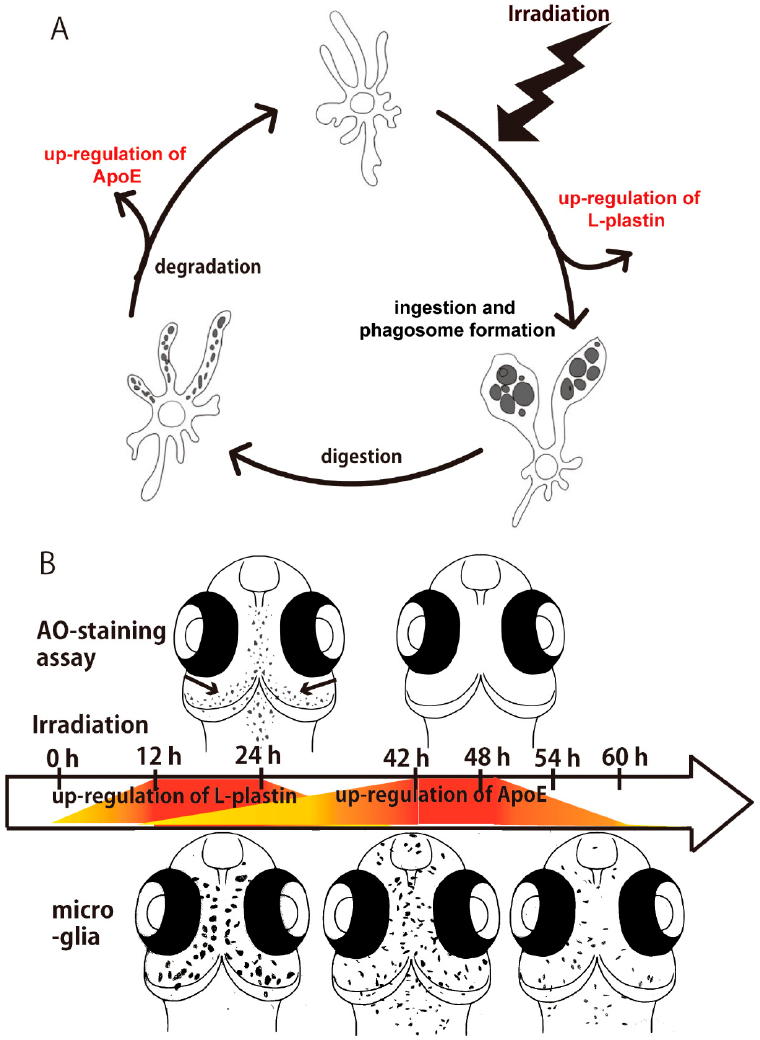
Figure 5. Sequential process of microglial activation in the irradiated medaka embryonic brain. ( A ) Activated microglia ingest apoptotic cells and form phagosomes to digest the cell debris. During the process of phagocytosis, L -plastin may be upregulated at the initial phase of microglial activation, especially in the process of ingestion of apoptotic cells. ApoE is expressed at the later phase of phagocytosis for clearance of cell debris in the microglial phagosomes; ( B ) Schematic images of sequential distribution of activated microglia expressing L -plastin and ApoE after irradiation.